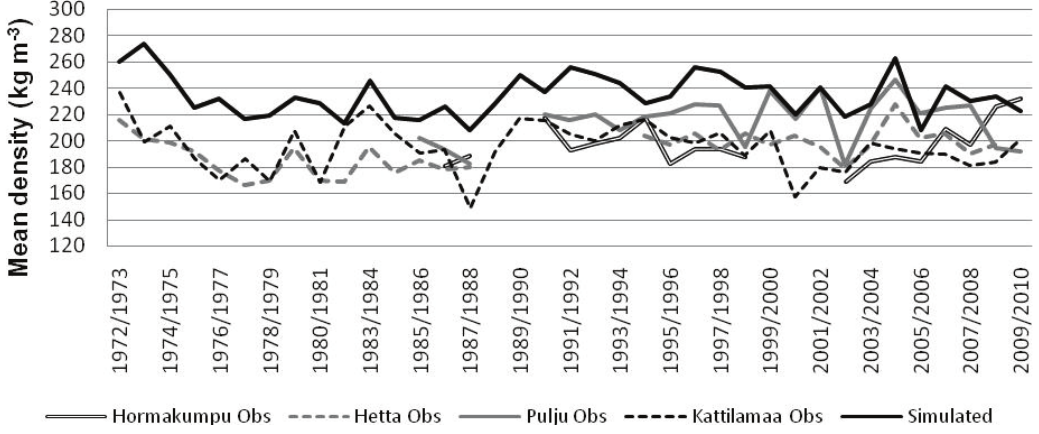
Figure 4. The mean snow density values (calculated from monthly values for whole winter) in open areas at four Finnish Environment Institute’s snow measurement lines and in the SNOWPACK simulations for open